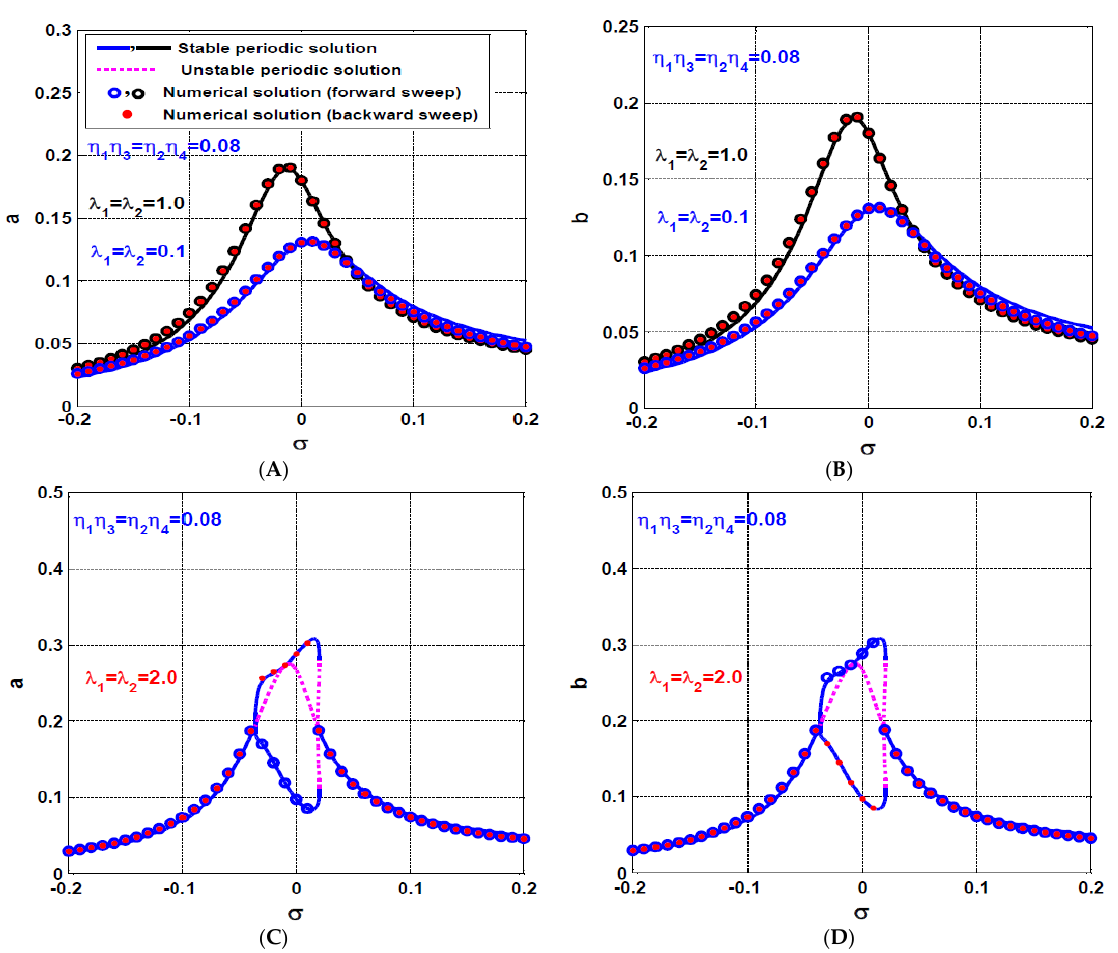
Figure 16. The rotor system 𝜎— response curve at three different values of the internal loops feedback gains 𝜆 1 and 𝜆 2 when 𝜂 1 𝜂 3 = 𝜂 2 𝜂 4 = 0.08 : ( A , B ) the system oscillation amplitudes a and b when 𝜆 1 = 𝜆 2 = 0.1,1.0 , and ( C , D ) the system oscillation amplitudes a and b when 𝜆 1 = 𝜆 2 = 2.0 .